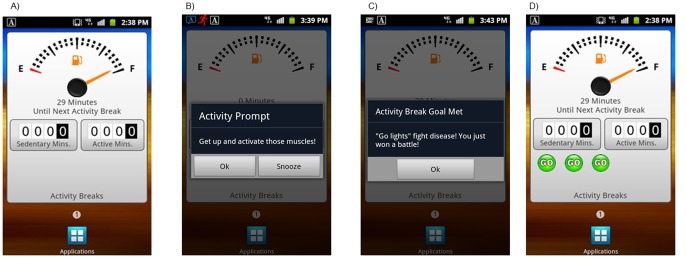
Smartphone display when A) smartphone is activated and idle, B) an activity prompt is presented, C) the onboard accelerometer detects that the activity break goal has been accomplished, D) “Go lights” have been earned by performing activity breaks following activity prompts.